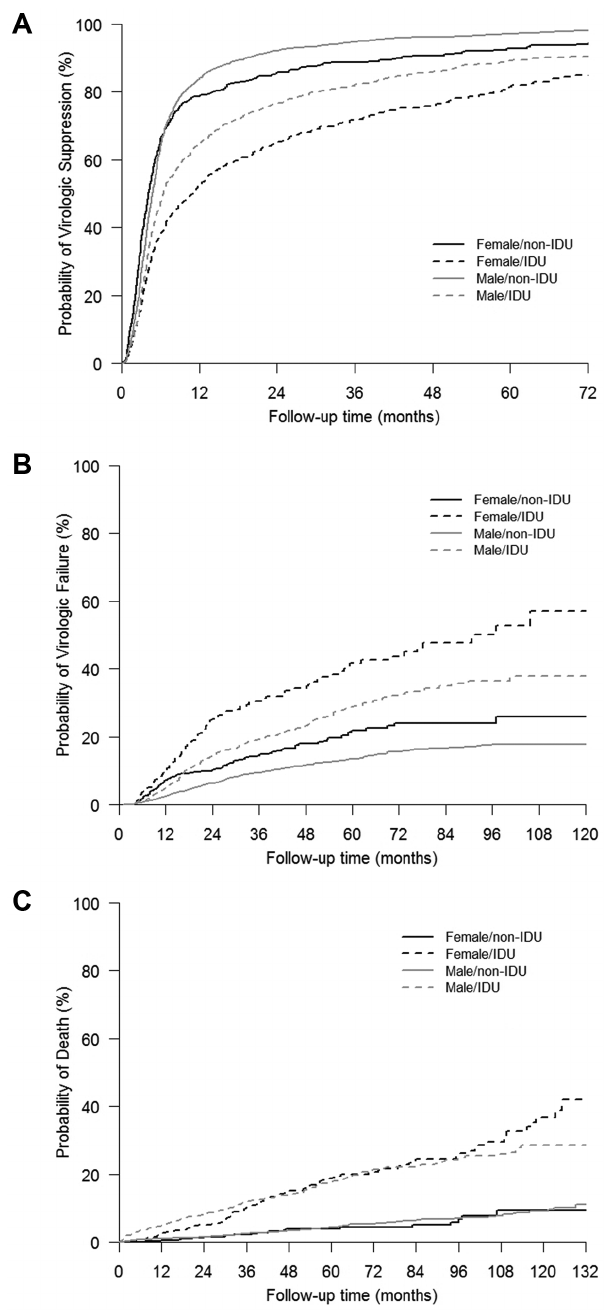
Figure 1. Time to virologic suppression (A), virologic rebound (B), and death (C) by gender and IDU